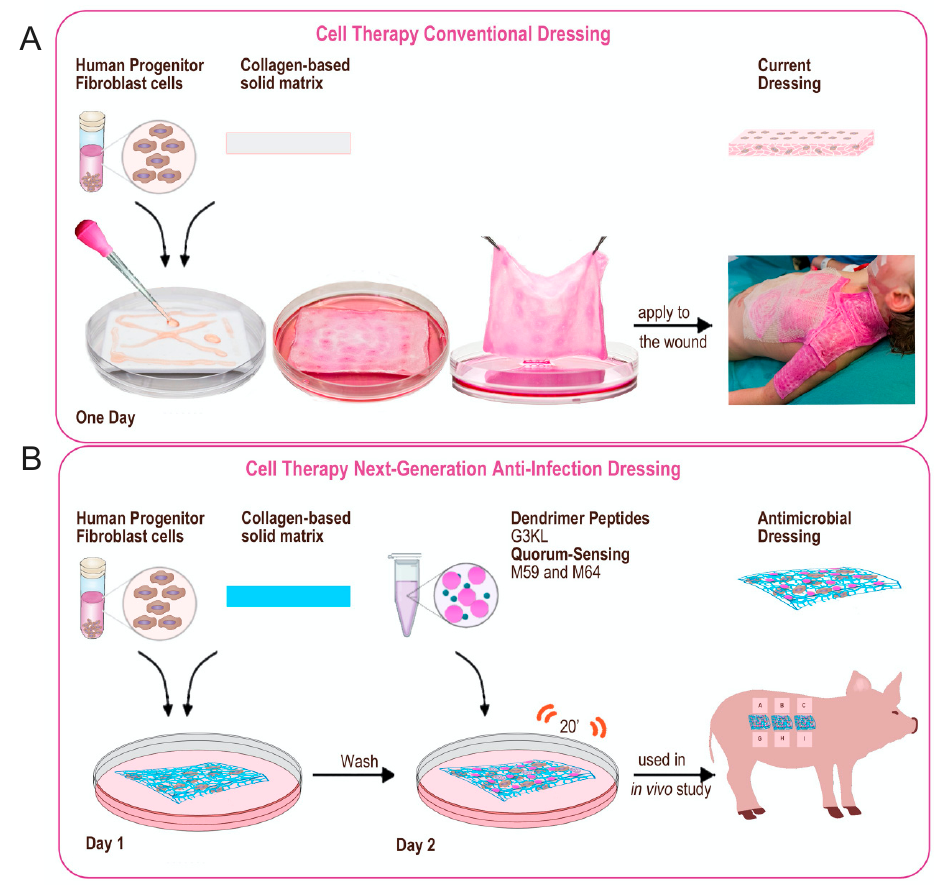
Figure 8. Final assembly of biological bandages. ( A ) first generation, ( B ) new anti-infection genera- tion.